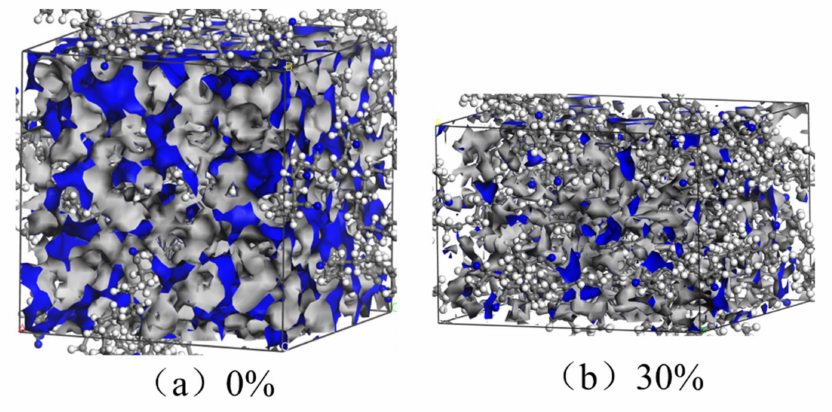
Figure 9. The Connolly volume morphology of NBR model in the uncompressed ( a ) and compressed ( b ) states, respectively (the blue and gray regions represent the free volume and the occupied volume,